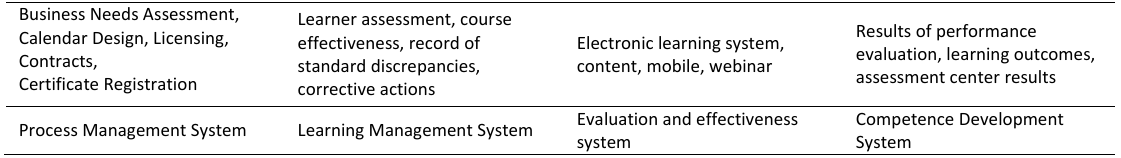
Table 1: ELearning dashboard management processes Table 1. ELearning dashboard management